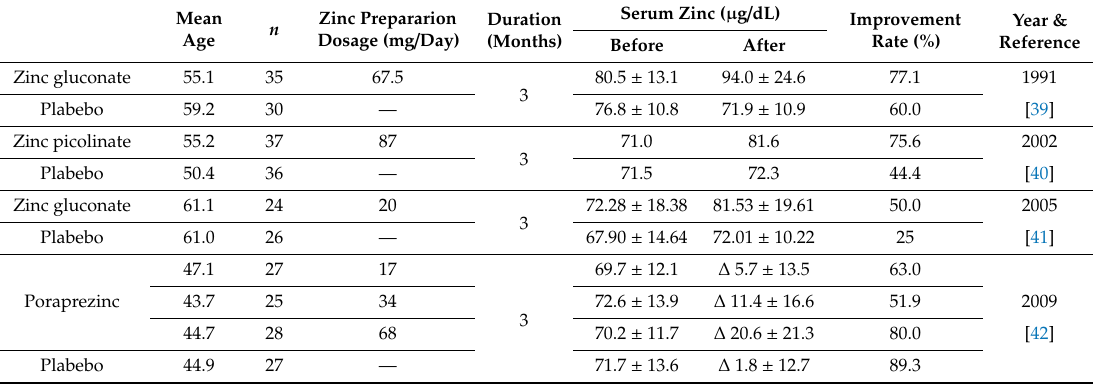
Table 4. E ff ects of zinc administration on zinc deficiency and idiopathic taste disorders. Mean Age